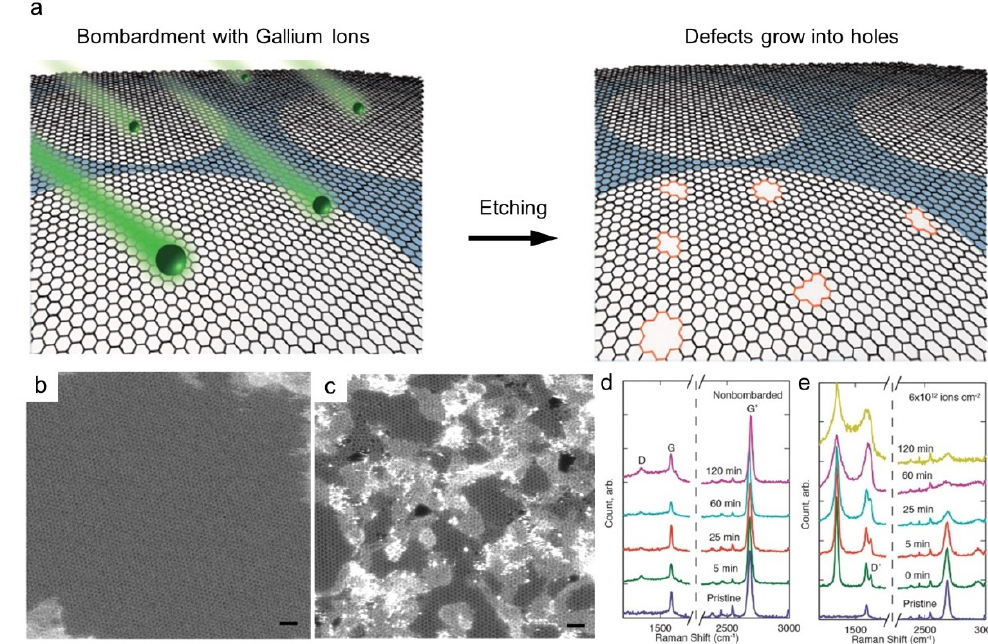
Figure 2. Membrane made of CVD-grown single layer graphene ( a ) Nanopore generation by ion bombardment followed by chemical oxidation. ( b , c ) TEM image of single layer graphene ( b ) and after ( c ) ion bombardment. Scale bars are 1 nm. ( d , e ) Raman spectra depending on chemical etching time and ion bombardment [25]. Copyright 2014 American Chemistry Society.